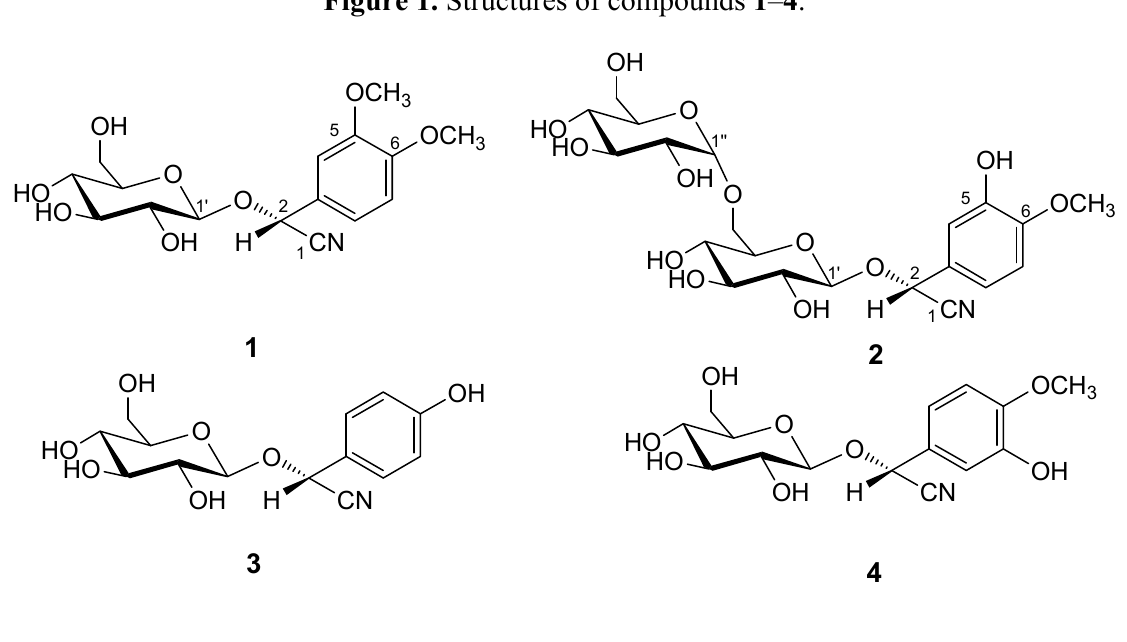
Figure 1. Structures of compounds 1 – 4